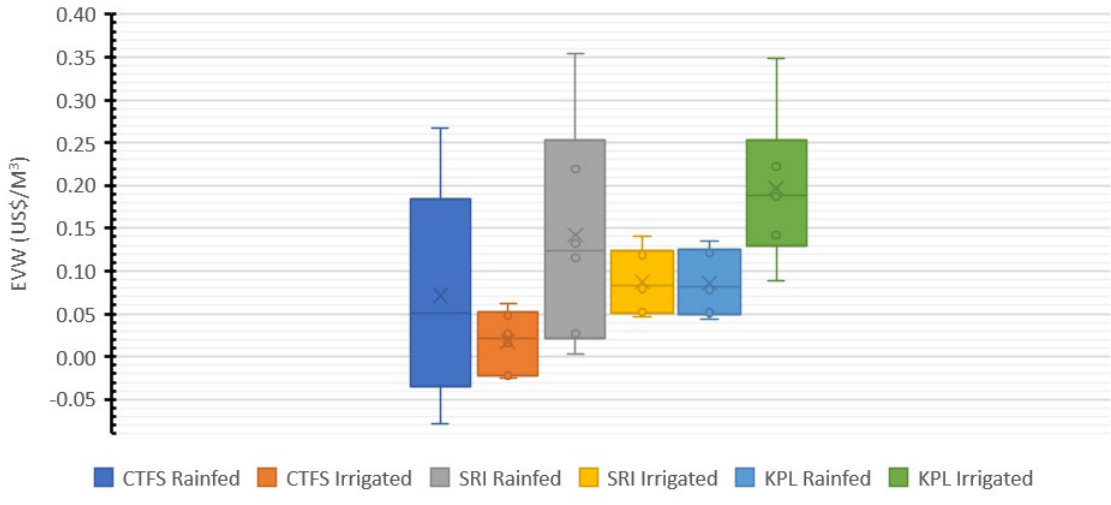
Figure 8. Comparison of the economic value of water for rice in all the six farming systems.